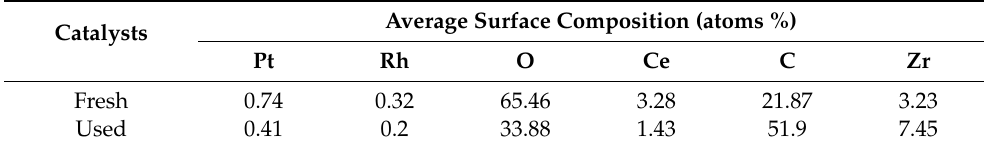
Table 3. Quantitative surface analysis of the Pt / Rh TWC catalysts based on XPS results.